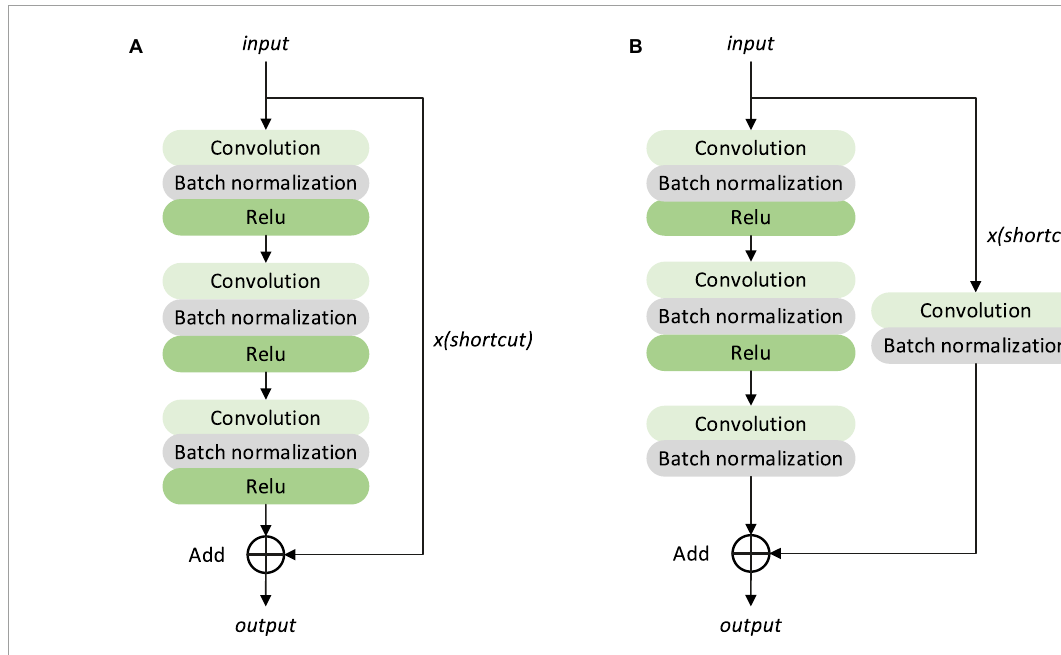
FIGURE12 Multi-Scale-X-ResNet network structure.